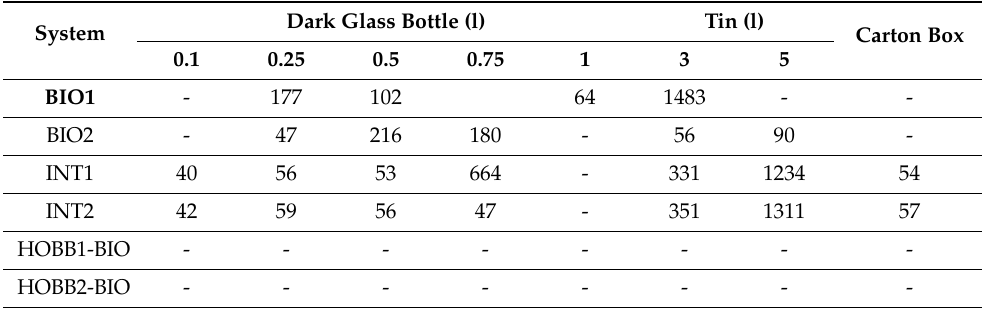
Table 10. Global warming (kg CO 2 eq ha –1 ) according to the packaging combination chosen by the analyzed systems.